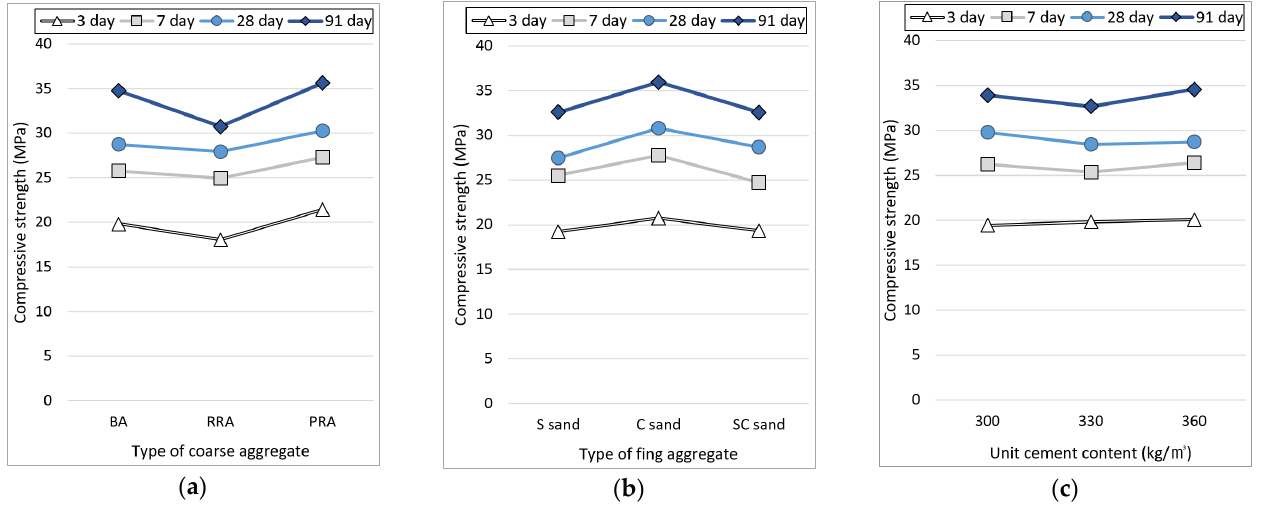
Figure 9. Compressive strength of the concrete depending on mixture conditions. ( a ) Coarse aggregate; ( b ) Fine aggregate; ( c ) Unit cement content.